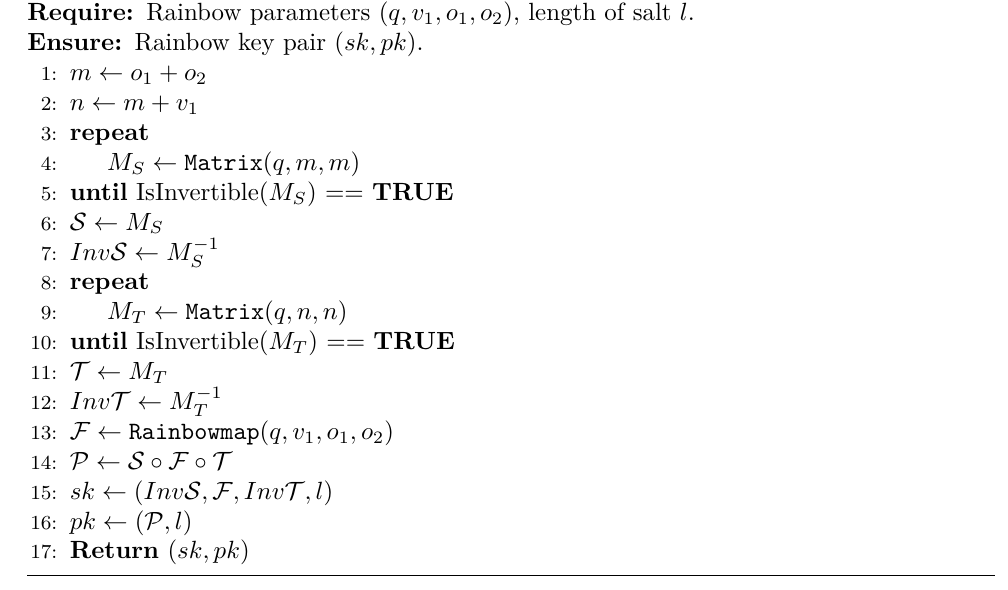
Algorithm 1 Rainbow Key Generation